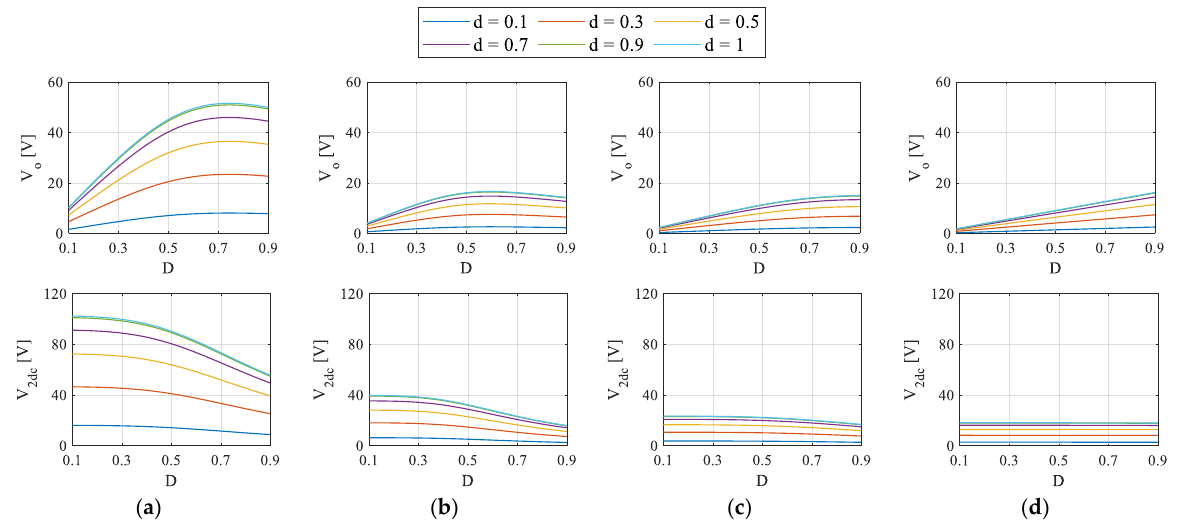
Figure 14. PR-IPTS output voltage V o (top) and intermediate bus voltage V 2 dc (bottom) vs. buck duty-cycle D for different values of normalized phase-shift d at: ( a ) f s = 70 kHz; ( b ) f s = 90 kHz; ( c ) f s = 110 kHz; and ( d ) f s = 135 kHz.